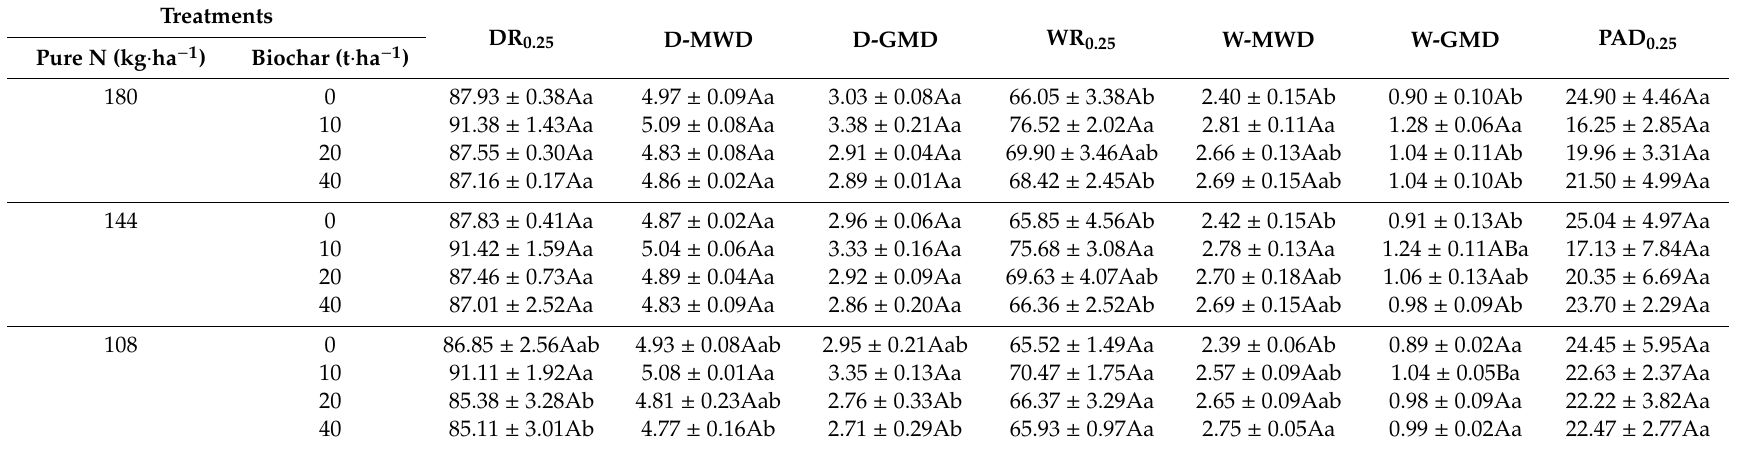
Table 3. Changes in soil aggregate ( > 0.25 mm) content, mean weight diameter, geometric mean diameter and percentage of aggregate destruction with di ff erent